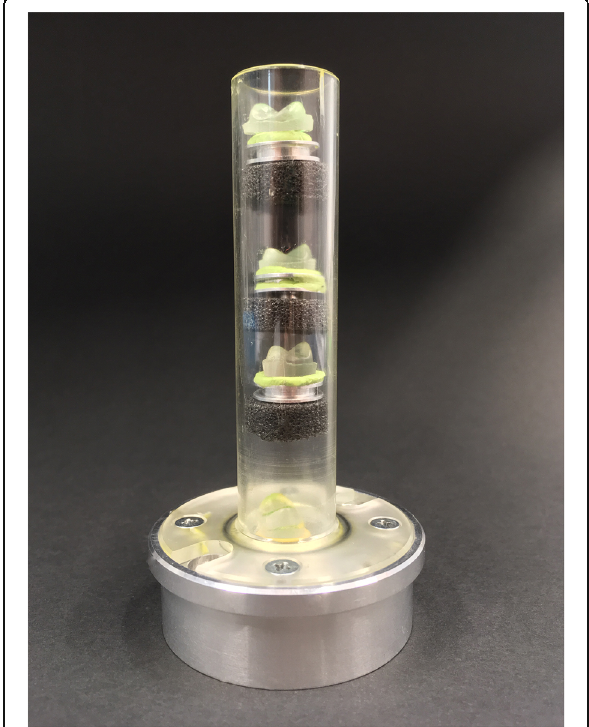
Fig. 2 Four replicas on specimen stubs and foam pellets in the sample holder of the Micro-CT